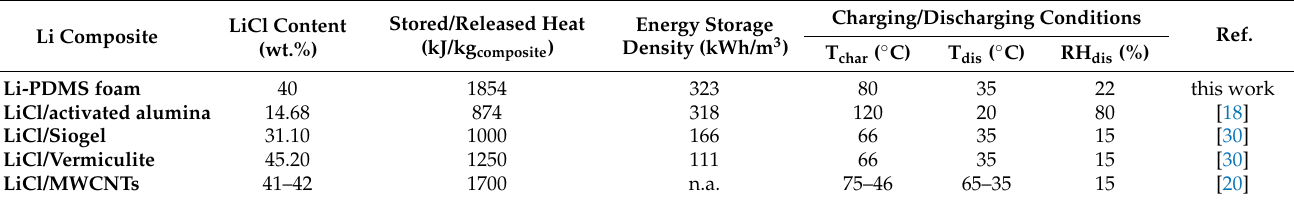
Table 2. Comparison of some LiCl-based composites’ energy densities and testing conditions. LiCl Content Li Composite